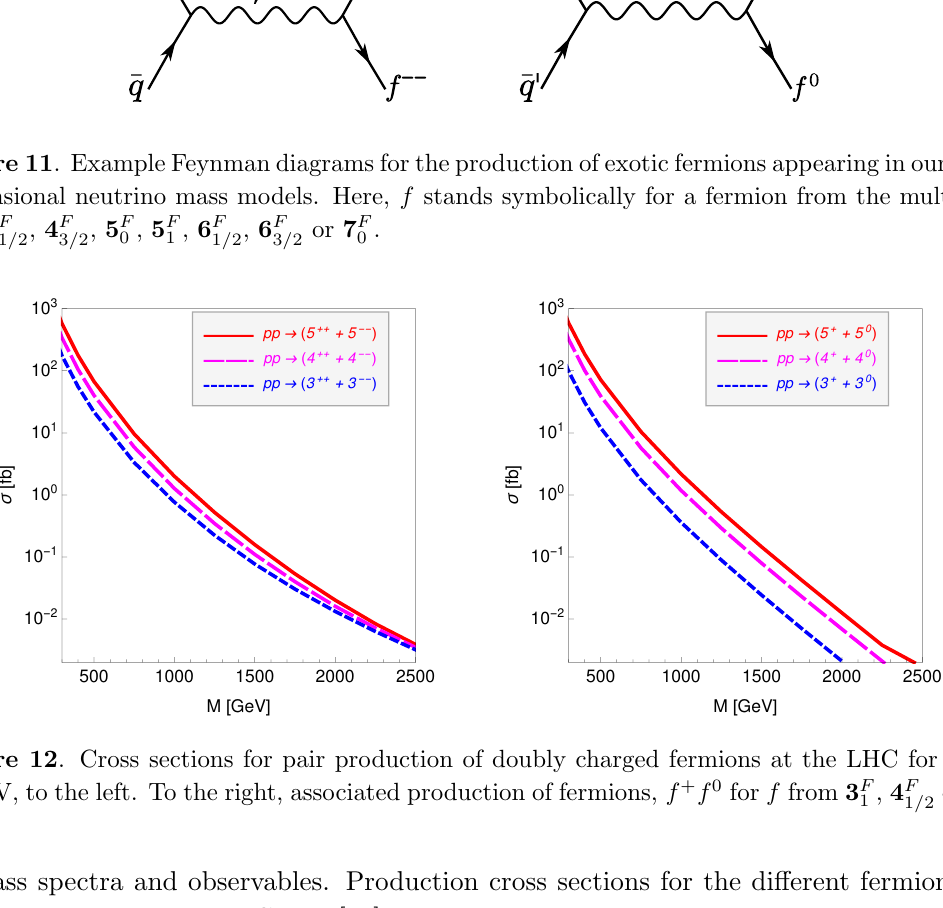
Figure 12 . Cross sections for pair production of doubly charged fermions at the LHC for 13 TeV, to the left. To the right, associated production of fermions, f + f 0 for f from 3 F of mass spectra and observables. Production cross sections for the di(cid:11)erent fermions are then calculated using MadGraph